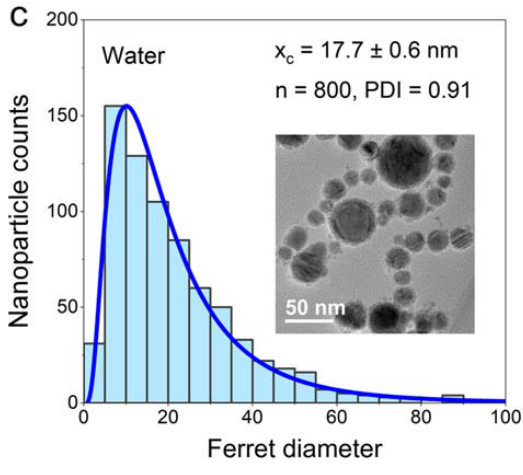
Figure 4. Number-weighted particle size distribution of FeNi NPs in ( a ) dried acetone, ( b ) acetone, and ( c ) water. FeNi NPs produced in dried acetone have the smallest median size and PDI, followed by FeNi produced in acetone, and FeNi produced in water. The number of counted particles (n) is denoted in the figures.